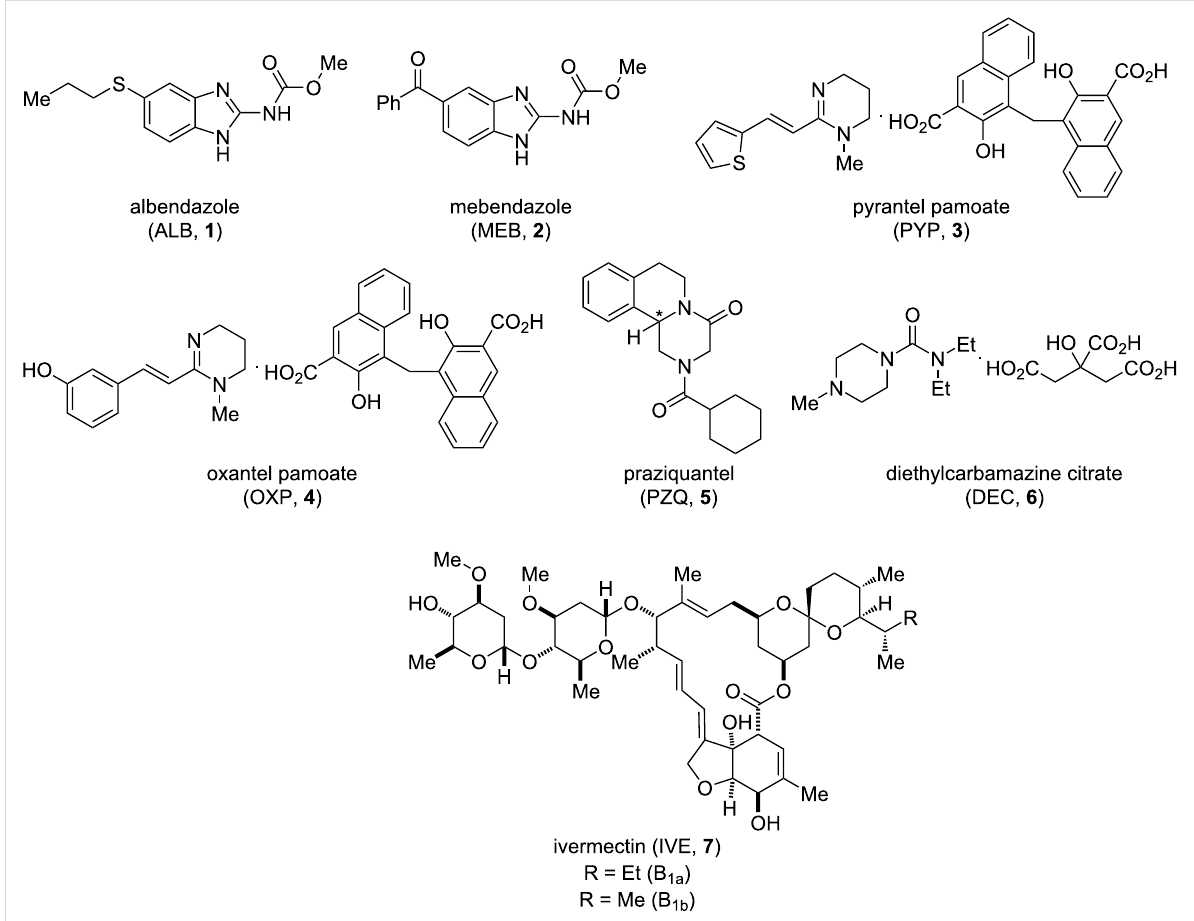
Figure 1: Structures of some current front-line anthelmintics discussed in this review. *Denotes the stereogenic centre: praziquantel is administered as a racemic mixture.